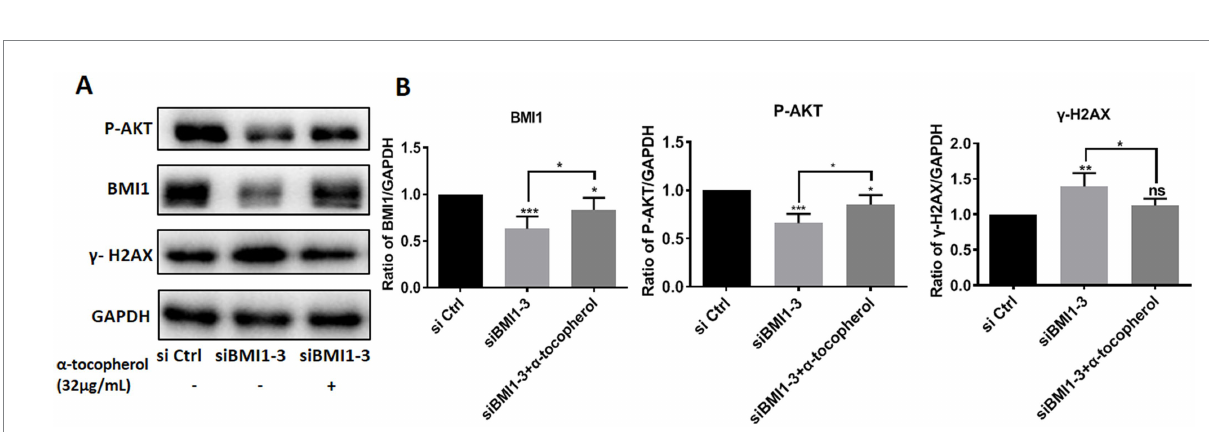
this reduction was restored by the combination of α -tocopherol and